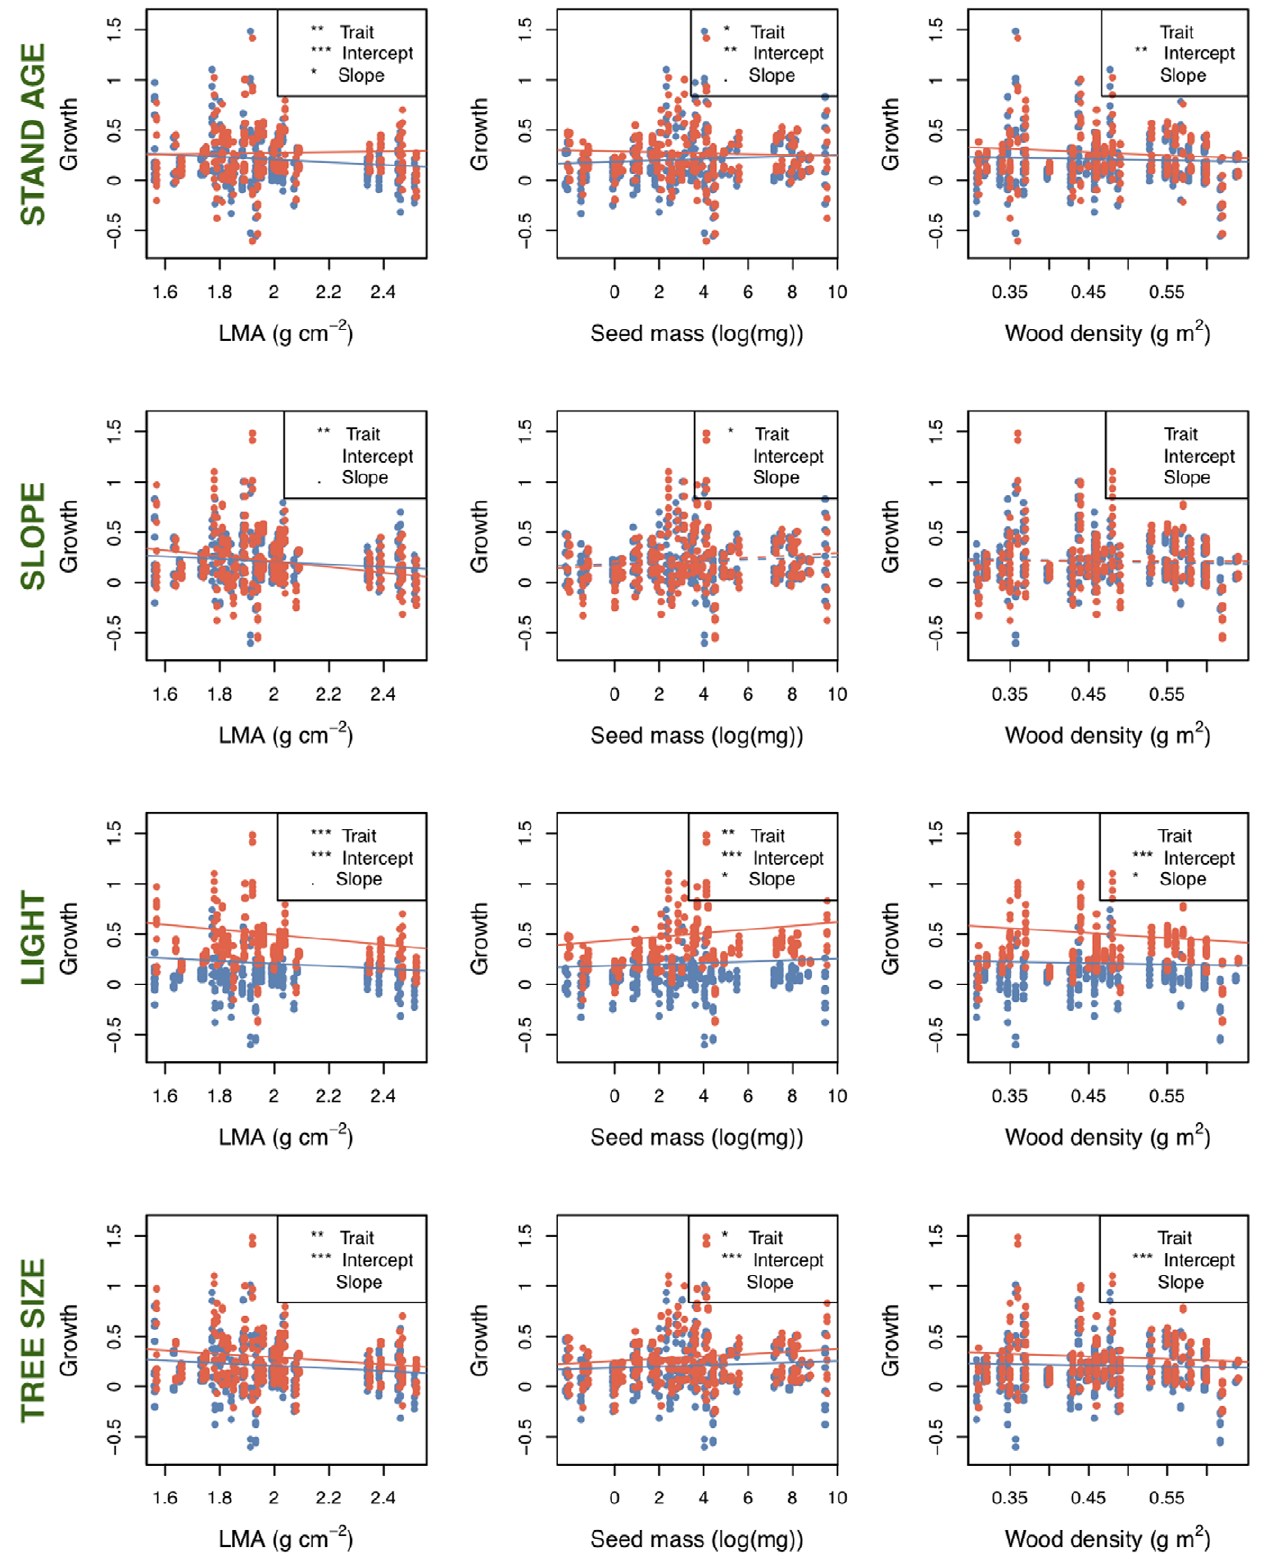
Figure 4. Growth versus functional traits with environmental and ontogenetic variables as covariates. Red slopes indicate old stands, plots on slopes, high light, and small trees, while blue indicates young stands, no slope, low light, and large tree levels. Light is the most important effect in these analyses, showing a strong positive shift to higher growth in high-light, regardless of the relationship between the traits and growth. There remains a great deal of scatter around these relationships, however, suggesting a need to test the variables and their interactions in a combined model (Table 2). ANOVA table details in Table 1. Significance codes for all figures: 0 ‘***’ 0.001 ‘**’ 0.01 ‘*’ 0.05 ‘.’ 0.1 ‘ ’ 1.